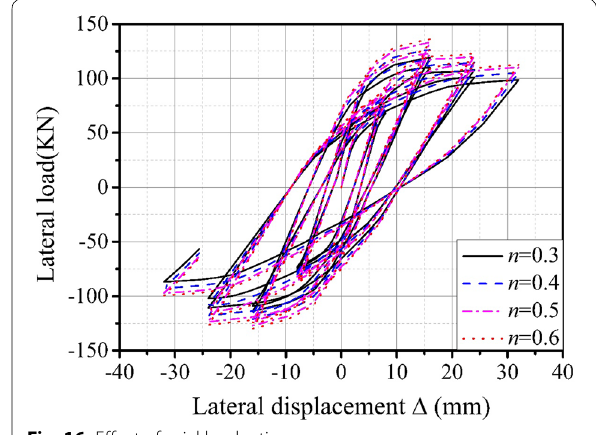
Fig. 16 Effect of axial load ratio.